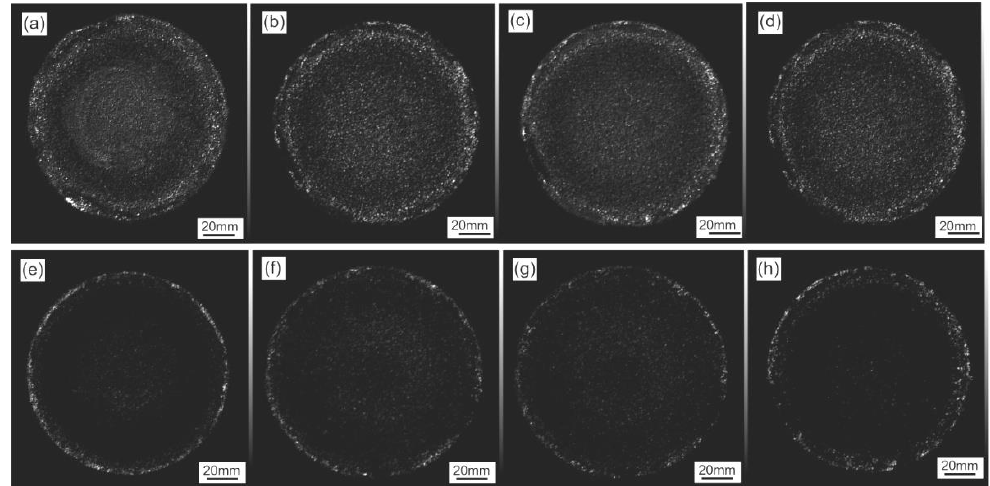
Figure 4. Scanning acoustic microscope (SAM) images in the cross section of 2A97 ingot prepared by conventional DC cast and LFEC with 10 Hz / 150 A ( a ) DC-4 mm layer; ( b ) DC-8 mm layer; ( c ) DC-12 mm layer; ( d ) DC-16 mm layer; ( e ) LFEC-4 mm layer; ( f ) LFEC-8 mm layer; ( g ) LFEC-12 mm layer; ( h ) LFEC-16 mm layer. Table 2. The statistical results of the casting defects in the SAM images of 2A97 as-cast ingots. Casting Condition Areal Fraction of Defects Number of Defects